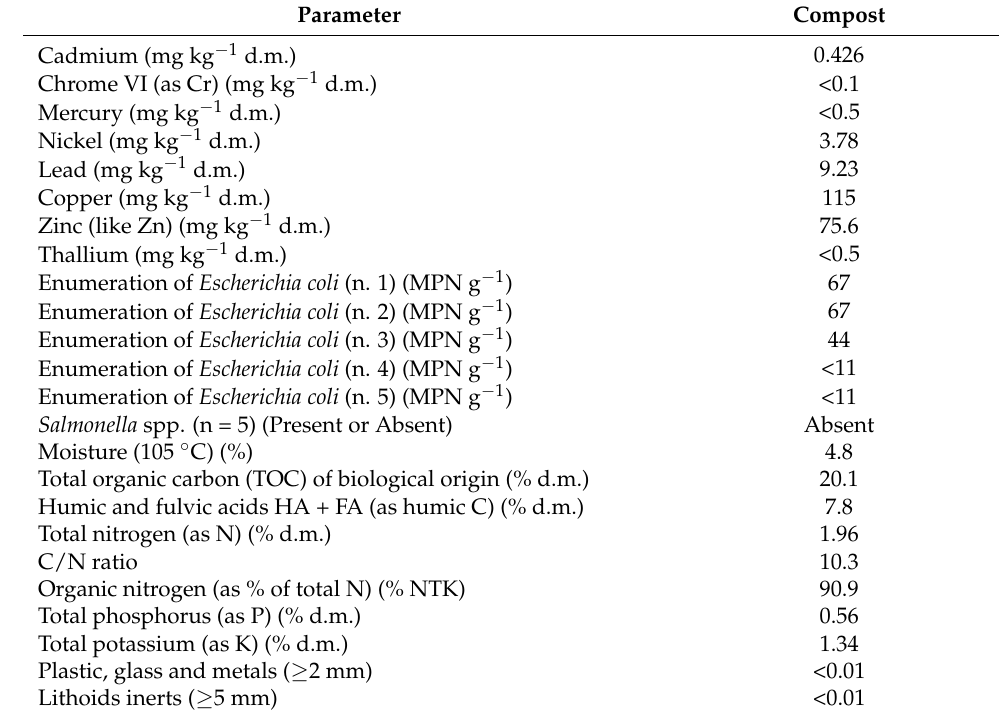
Table 1. Properties of green compost used in the experiment, released by the external laboratory (Cierre S.r.l., Arezzo, Italy). Parameter Compost Cadmium (mg kg − 1 d.m.)